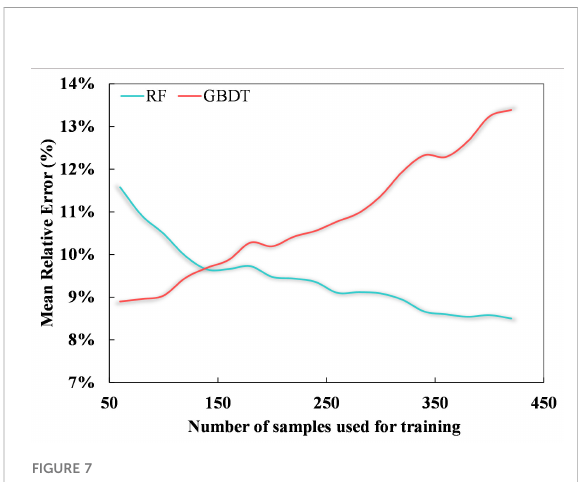
FIGURE 7 The variation in the mean relative error of RF (cyan) and GBRT (red) estimation results with increasing sample size on the validation